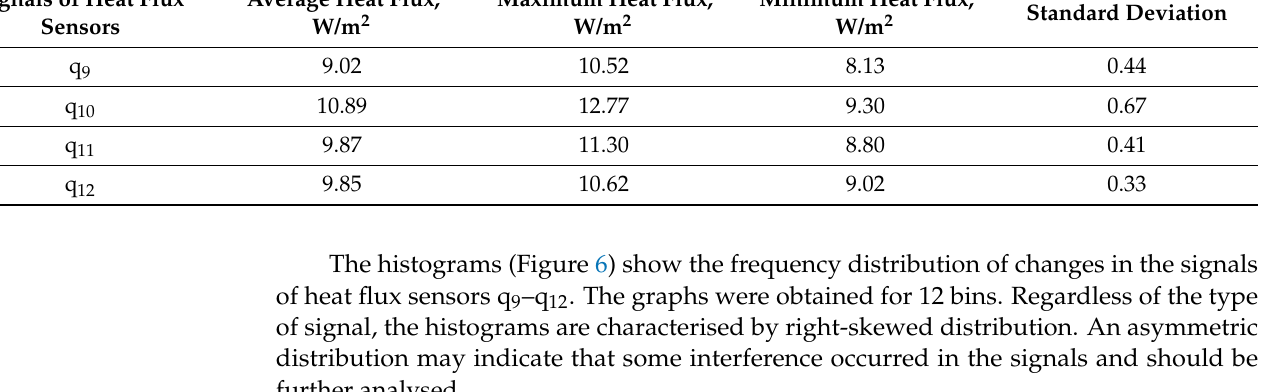
Figure 5. Photo of the scheme of placing the heat flux sensors on the outer side of the building wall under investigation.